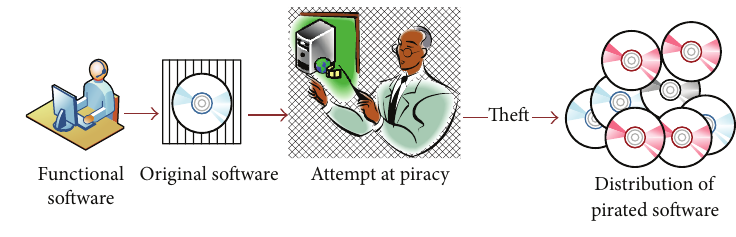
Figure 1: Software